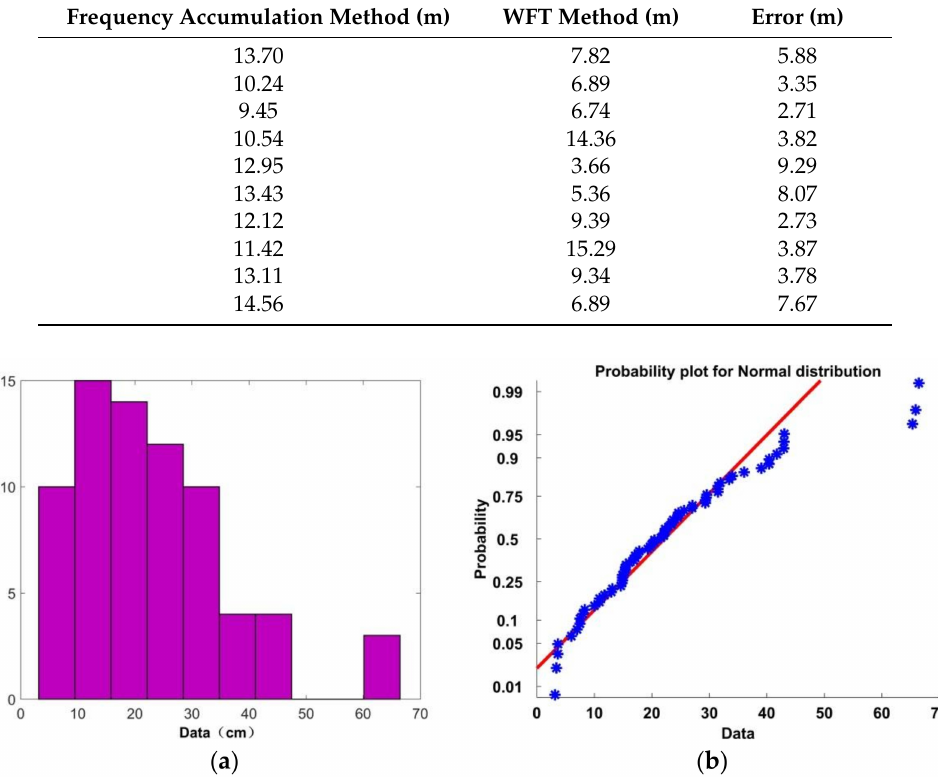
Table 5. Range estimates and errors without a human subject.